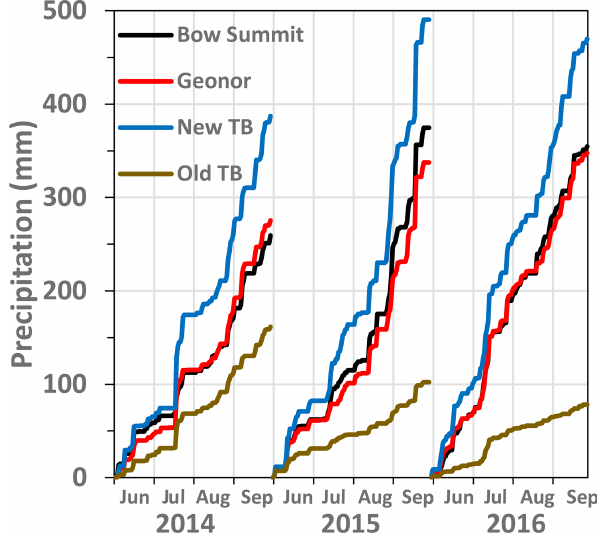
Figure 6. Cumulative rainfall comparisons at the Peyto Main sta- tion and Bow Summit over the summer